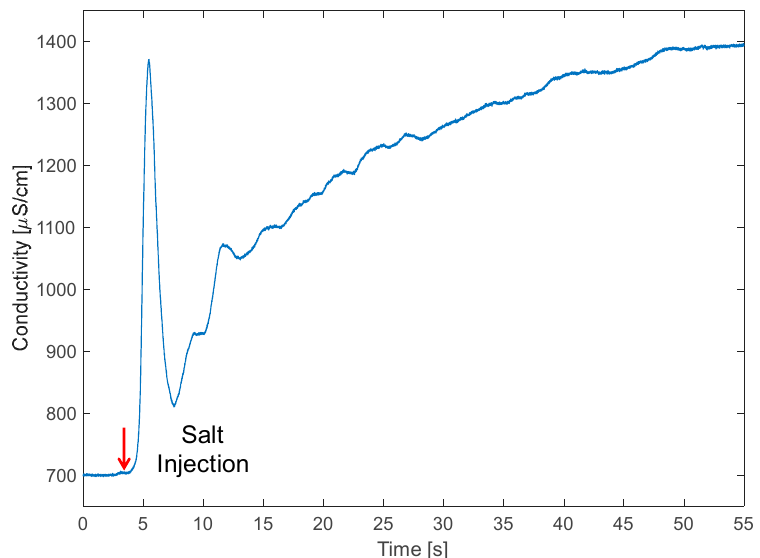
Figure 8. Time tracking of the real part of impedance at 20 MHz during a conductivity increase produced by the injection of 50 g of NaCl in the tank.